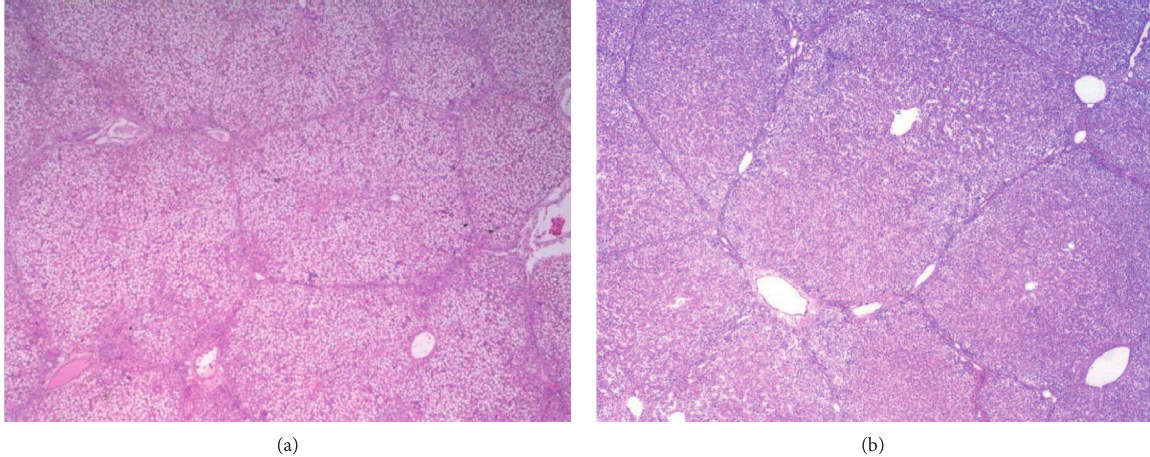
Figure 2: Optical microscopy image, HE 2x dyeing with 95% steatosis (a) and optical microscopy image, HE 2x dyeing with 40% steatosis